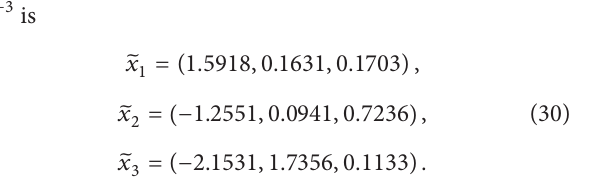
Table 2: Finding the mean values.